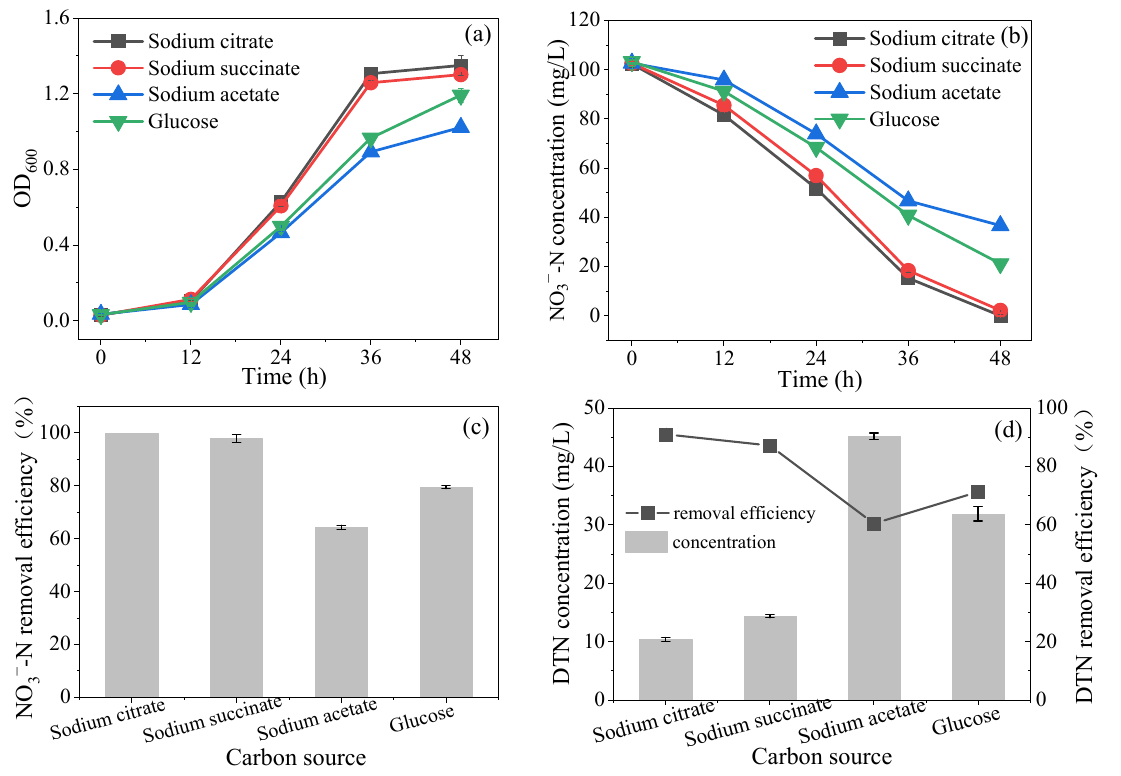
Figure 4. Nitrogen removal characteristics of strain 41 under different carbon sources: ( a ) growth curves of strain 41; ( b ) variation of NO 3 − -N concentration; ( c ) removal efficiency of NO 3 − -N; ( d ) characteristics of DTN removal.